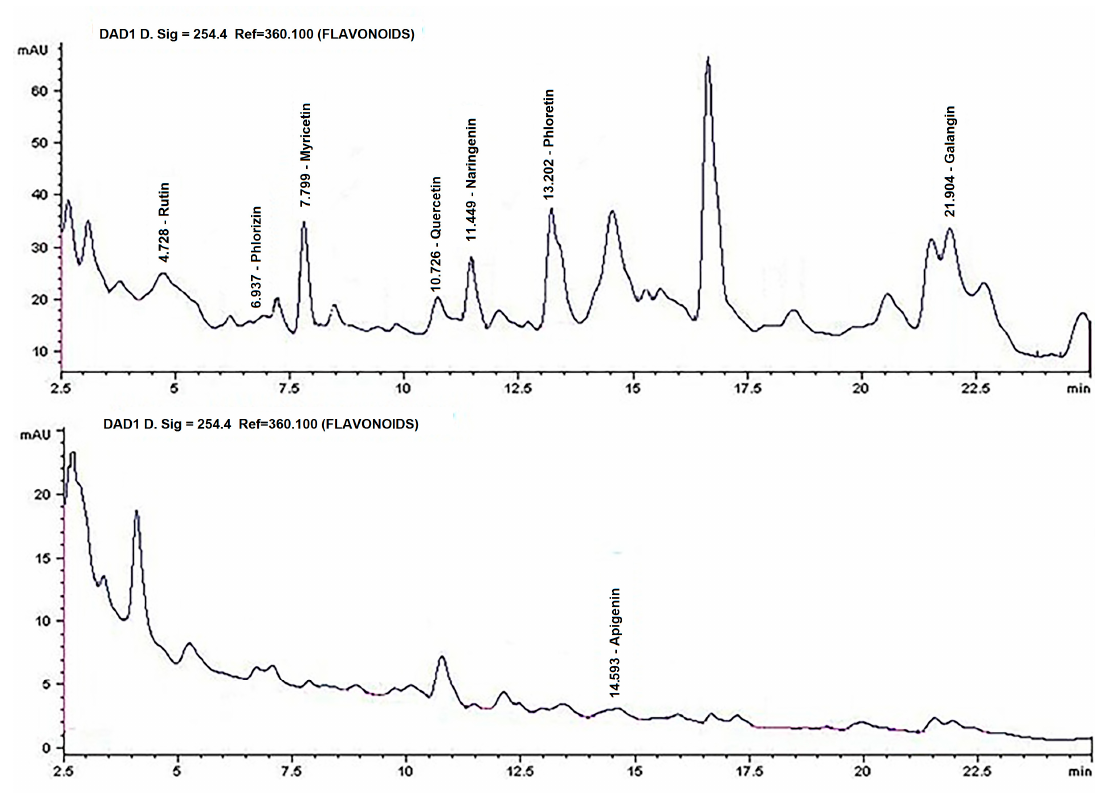
Figure 4. Identifying compounds by HPLC. ( A ) Chromatograms of the flavonoid fractions that showed biological activity, obtained from the methanolic extract of Perla Negra through column chromatography at 254 nm; and ( B ) the presence of Apigenin at 316 nm and unidentified compounds.